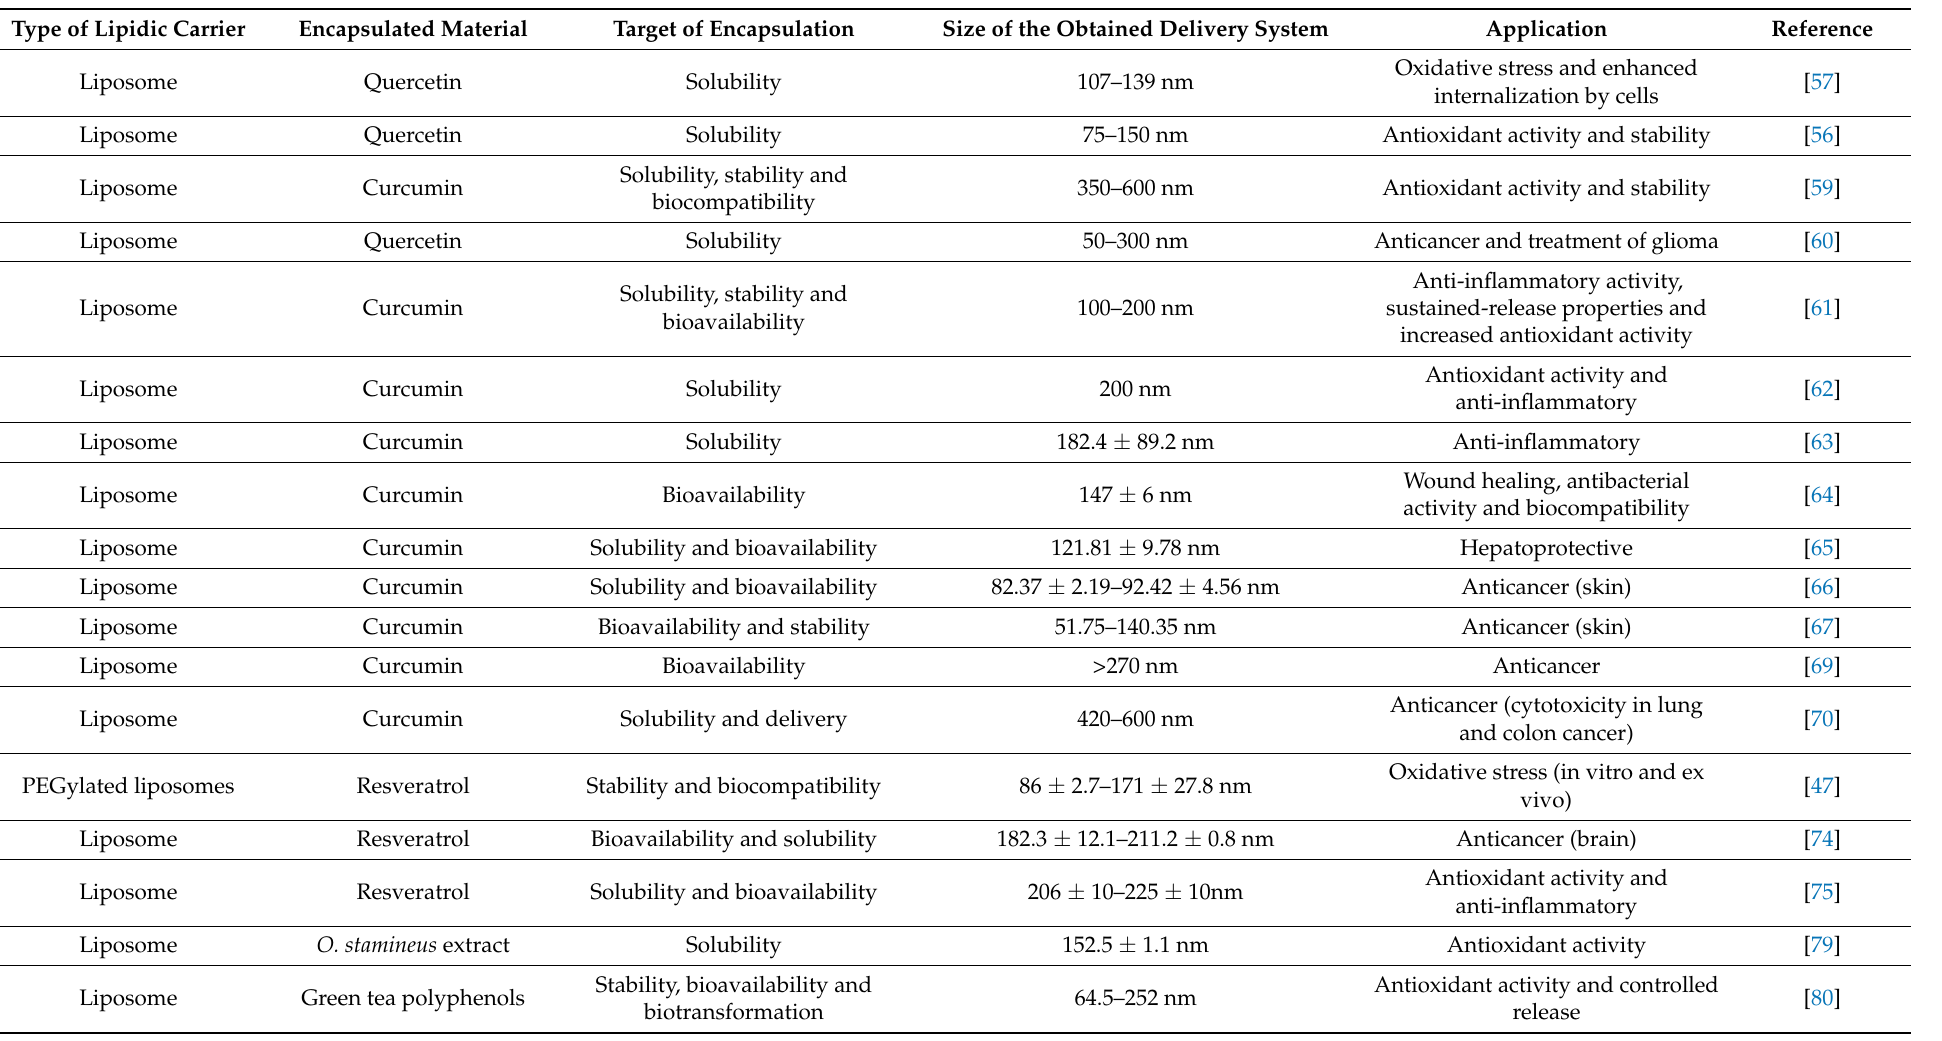
Table 1. Overview of different lipid-based delivery systems that have been used for the encapsulation of various pure plant bioactive compounds, extracts and essential